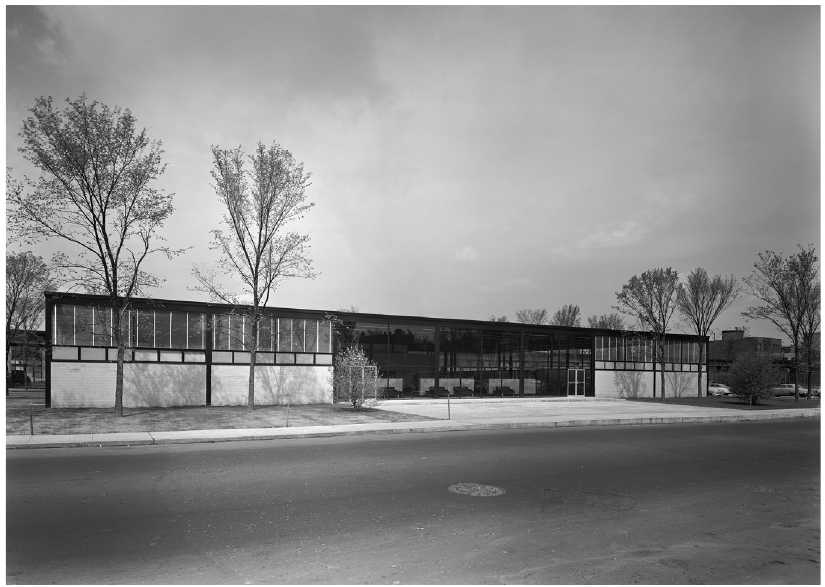
Figure 1. Exterior view of the Commons Building at IIT (photographer: Hedrich-Blessing), courtesy Chicago History Museum